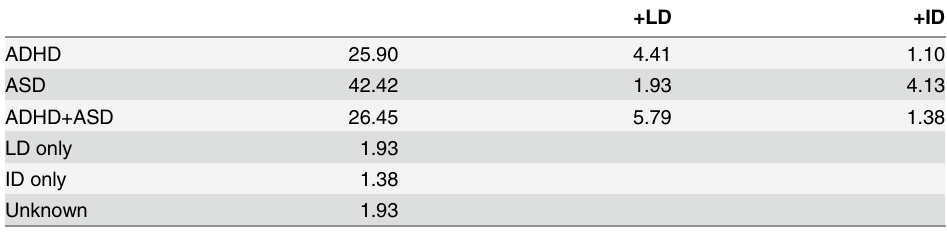
Table 2. Type of diagnosis